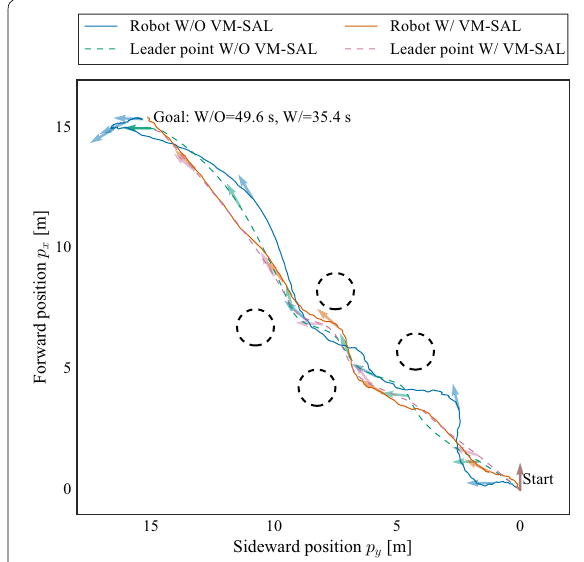
Fig. 8 Trajectories of the robot and the leader point from the start to the goal in both cases, the robot could track the leader point to the goal without avoiding the